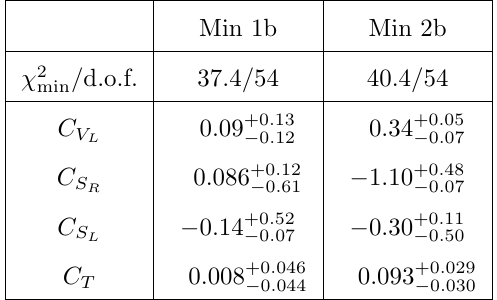
Table 8 . Minima and 1 (cid:27) uncertainties obtained from the global (cid:31) 2 minimization, including the new HFLAV world average on the ratios (cid:28) (cid:22) (cid:23) (cid:28) ) < 10%. There are, in addition, the corresponding sign-(cid:13)ipped minima, as indicated in eq.